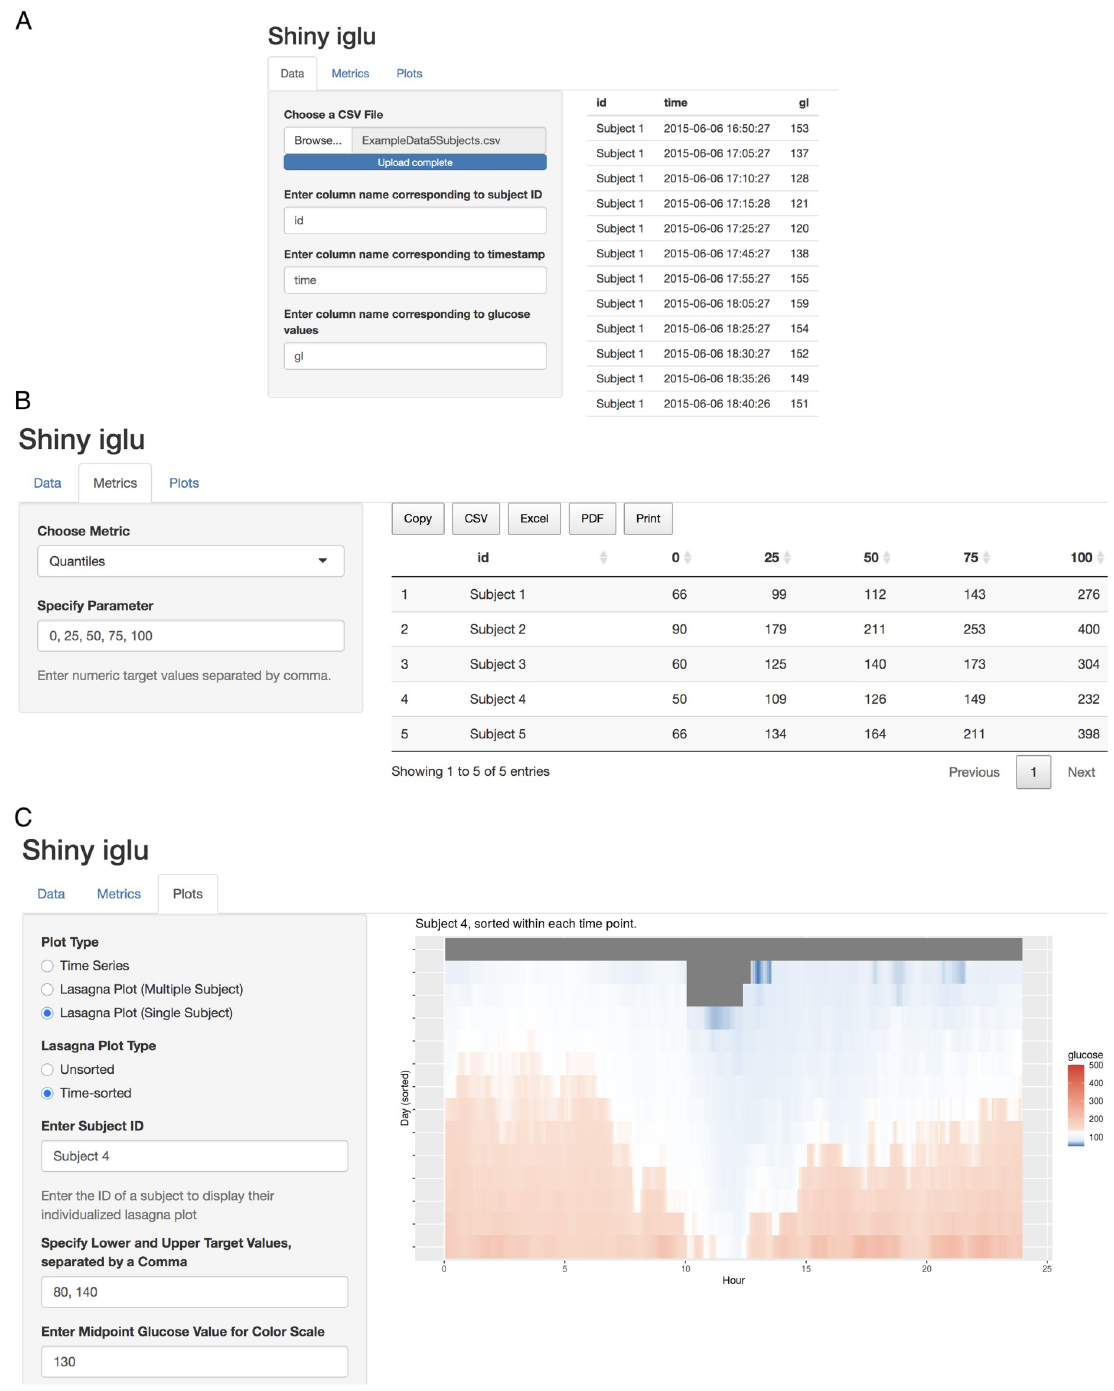
Fig 7. Shiny GUI interface for iglu . (A) loading CGM data in .csv format; (B) calculating user-specified quantiles for each subject; (C) creating customized lasagna plot for the selected